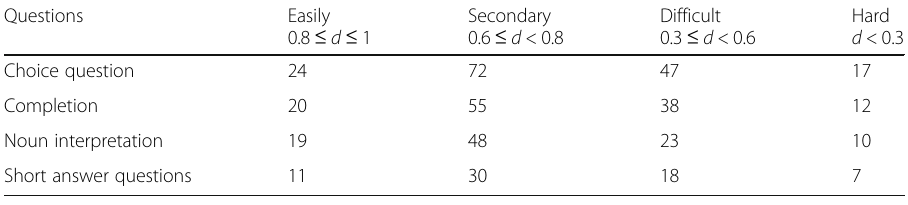
Table 3 The difficulty distribution of question bank